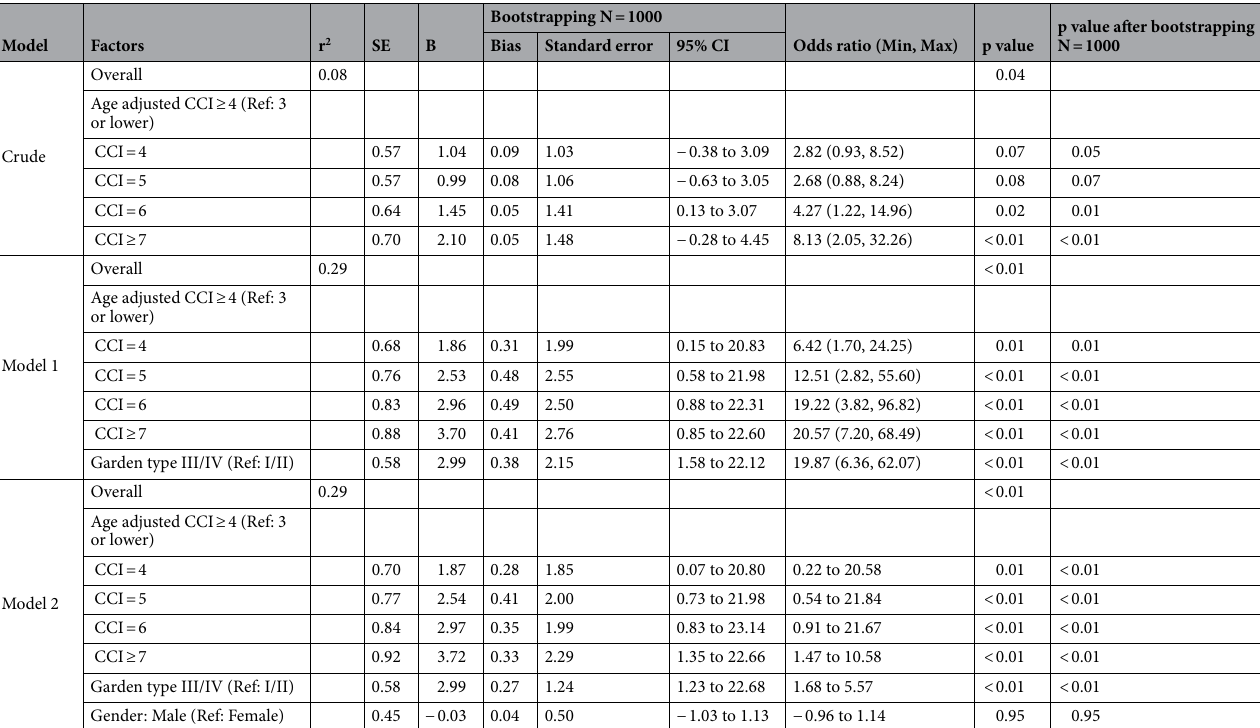
Table 3. Stepwise logistic regression models on any complication using age-adjusted Charlson Comorbidity Index (ACCI) and different confounding factors (Crude = ACCI, Model 1 = ACCI + Garden Type, Model 2 = ACCI + Garden Type + Gender). Bias, its standard error (Standard error) and 95% confidence intervals (95% CI) of B after bootstrapping for N = 1000 were